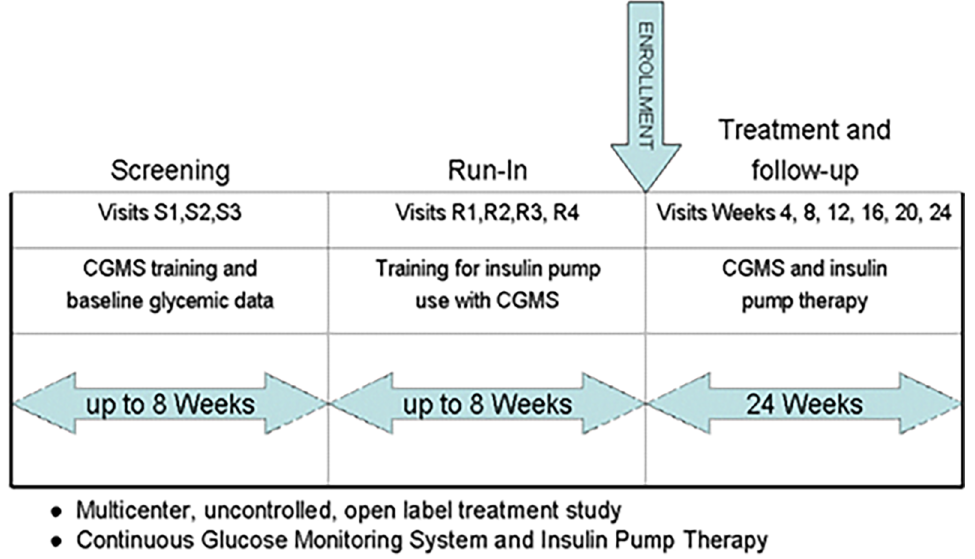
Fig 2. Study design for GLUMIT-DG. The study design is shown. After an initial screening phase (up to 3 visits over up to 8 weeks), a run-in phase (up to 4 visits over up to 8 weeks) was conducted. The formal treatment phase consisted of 6 study visits over 24 weeks when CSII and CGM were used together to optimize glycemic control.